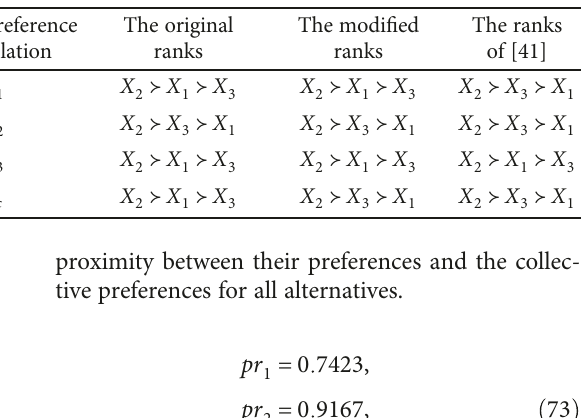
Table 4: The rankings before and after the modi fi